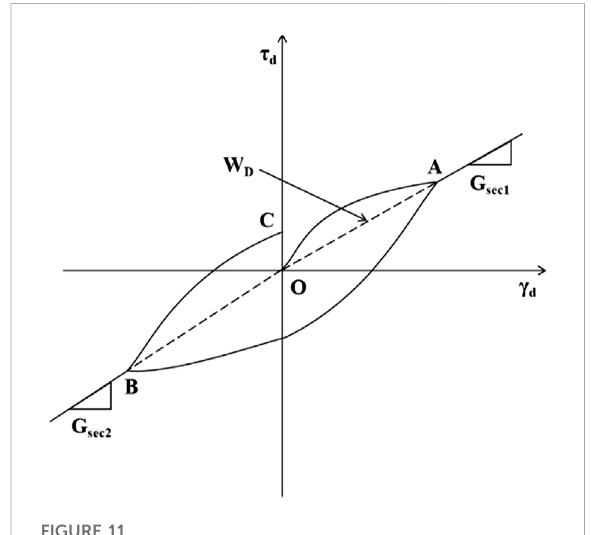
FIGURE 11 De fi nition of the dynamic shear modulus based on the hysteretic shear stress-strain loop.